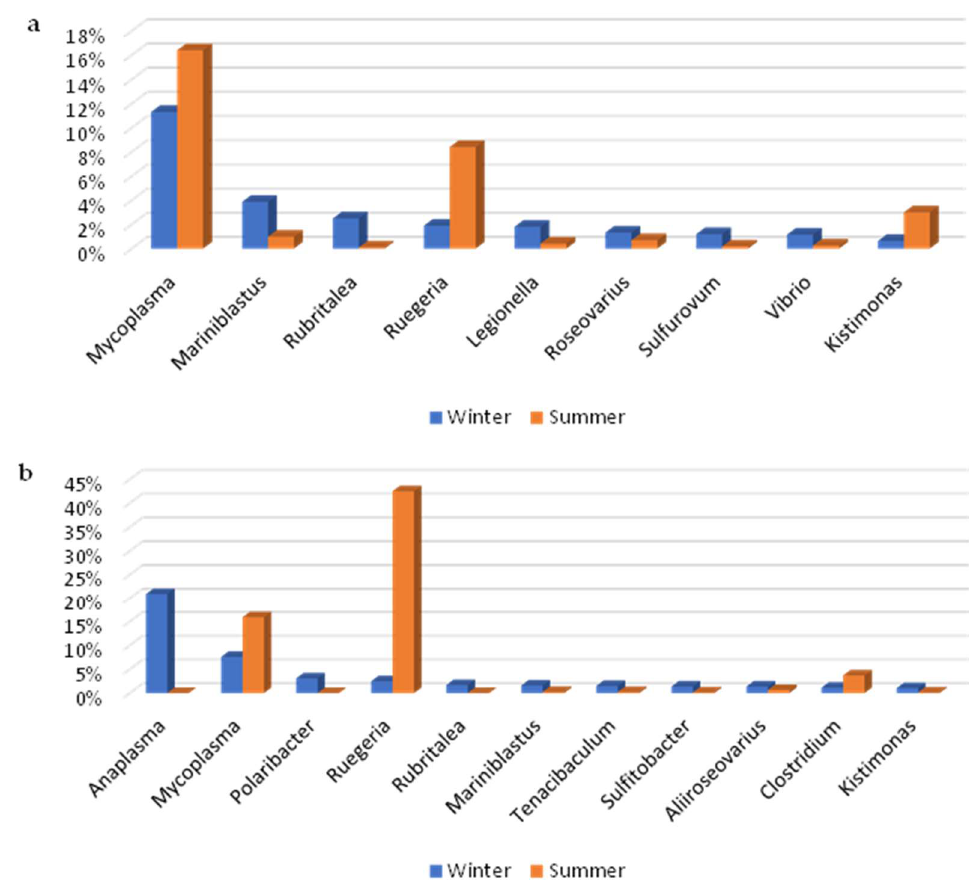
Figure 5. Comparison of the most abundant bacterial genera between ( a ) winter-summer in Chalastra region and ( b ) winter-summer in Makrigialos region .